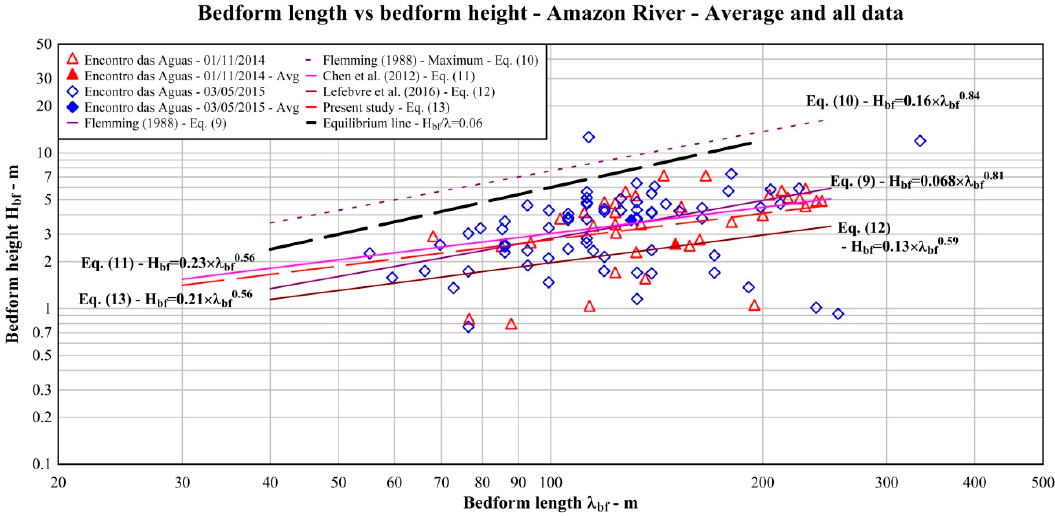
Figure 12. Bedform wavelength vs. bedform wave height.